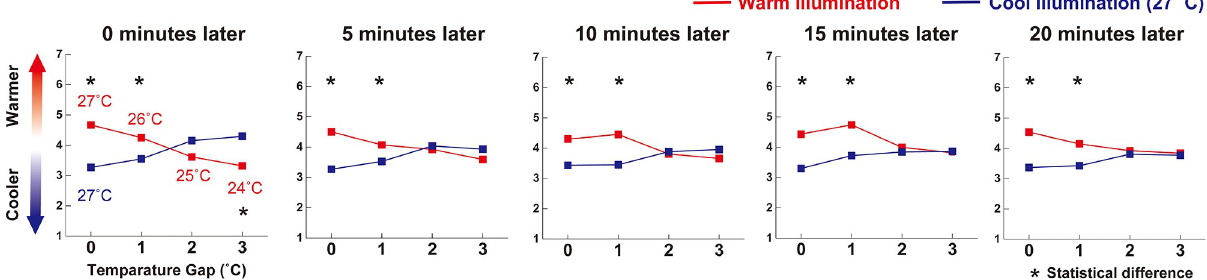
Fig 2. Results of mean subjective evaluations for perceived temperature in warm illuminated and cool illuminated rooms, at 0, 5, 10, 15, and 20 minutes. This clearly indicates that a sensation of coolness/warmness is manipulated by illumination.